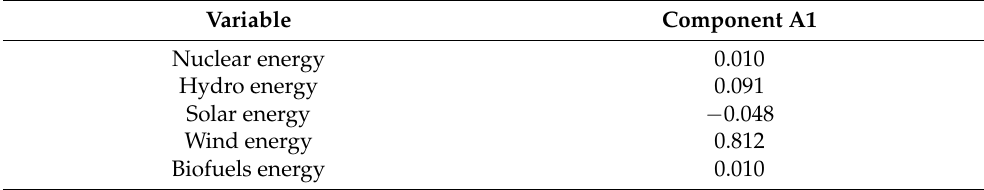
Table 3. Factor loadings of green energy consumptions in component